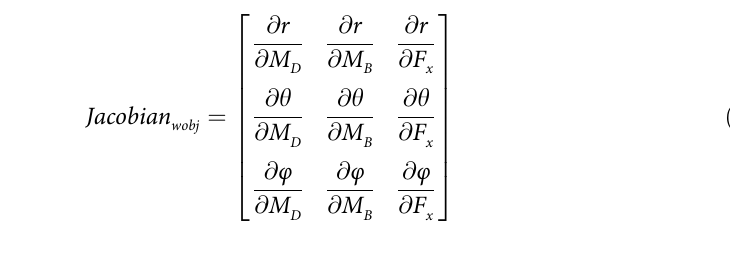
and φ , wobj wobj